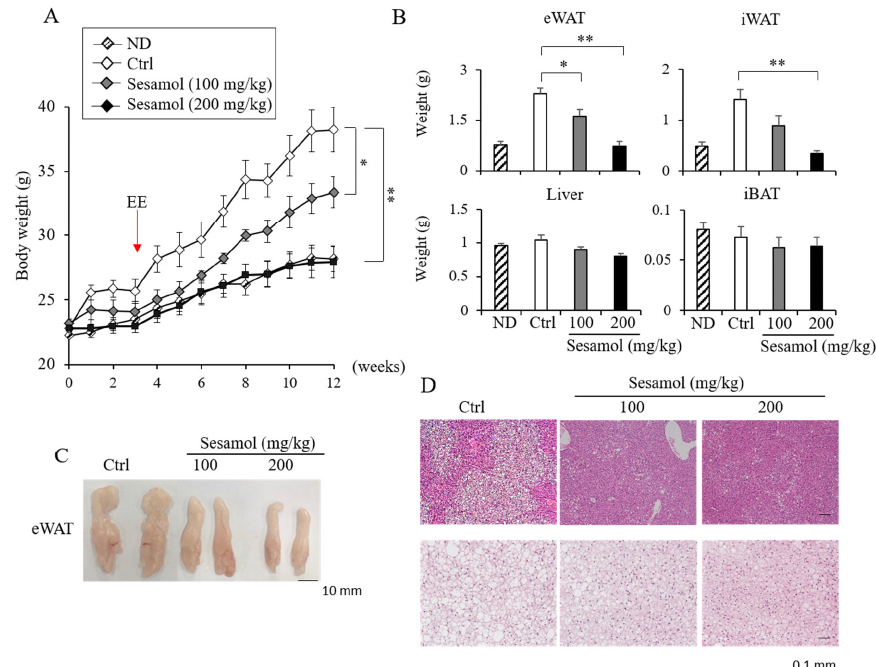
Figure 2. Oral administration of sesamol prevents obesity in high-fat diet (HFD)-induced obese mice. ( A ) Body weights of vehicle control- or sesamol-treated mice. Eight-week-old male C57BL / 6J mice were fed with normal diets (ND) or high-fat diets (HFD, 60% fat) and orally administrated with the vehicle control or sesamol (100 mg/kg and 200 mg/kg per day) up to 12 weeks ( n = 5 per group). Energy expenditure (EE) was measured at 3 weeks of treatments. ( B ) Differences in epididymal white adipose tissue (eWAT), inguinal white adipose tissue (iWAT), liver, and interscapular brown adipose tissue (iBAT) weights in control- and sesamol-treated groups. ( C ) Representative images of eWAT from control- or sesamol-treated mice. Scale bar, 10 mm. ( D ) Representative hematoxylin and eosin (H and E) staining for sections of liver and eWAT from HFD-fed mice. Scale bar, 0.1 mm. Data represent mean ± s.e.m. Statistically significant differences between the control- and sesamol-treated mice were determined by Student’s t -test (* p < 0.05; ** p < 0.005).